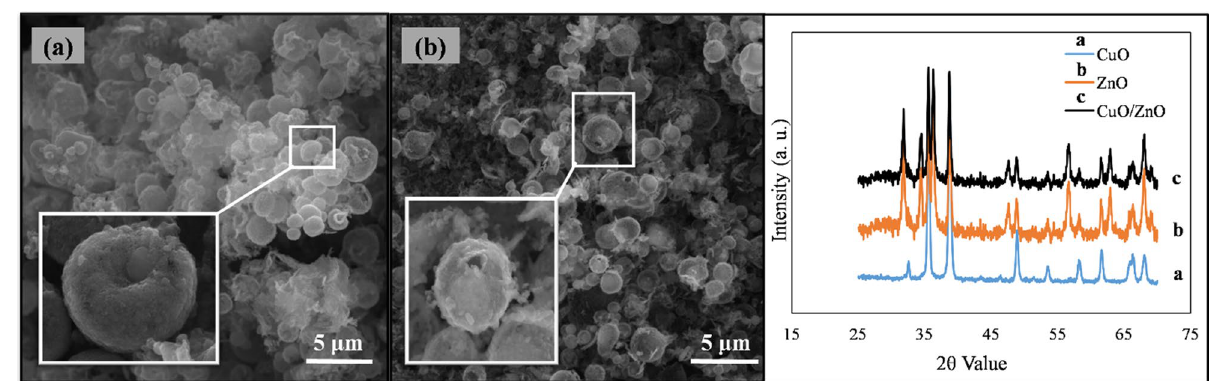
Figure 3. SEM micrographs of ( a ) CuO-MS and ( b ) ZnO-MS, ( c ) XRD patterns of as-synthesized CuO/ZnO-